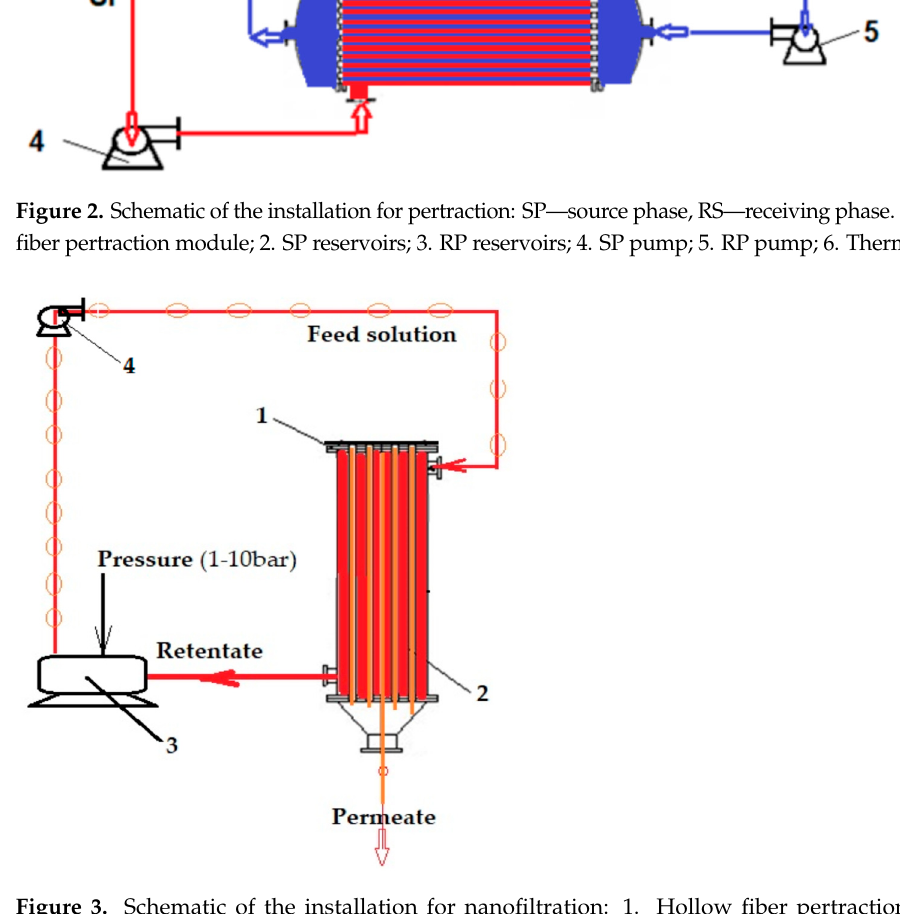
Figure 3. Schematic of the installation for nanofiltration: 1. Hollow fiber pertraction module; 2. Composite membranes; 3. Pressure reservoir; 4. Recycling pump.